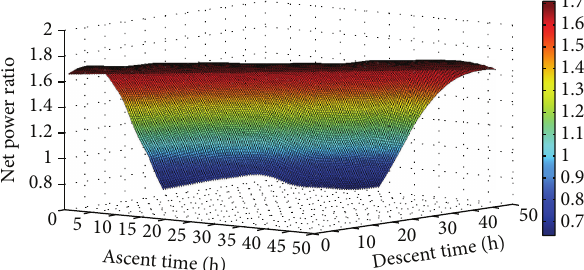
Figure 5: Trend of the power ratio at the initialization of the descent phase.